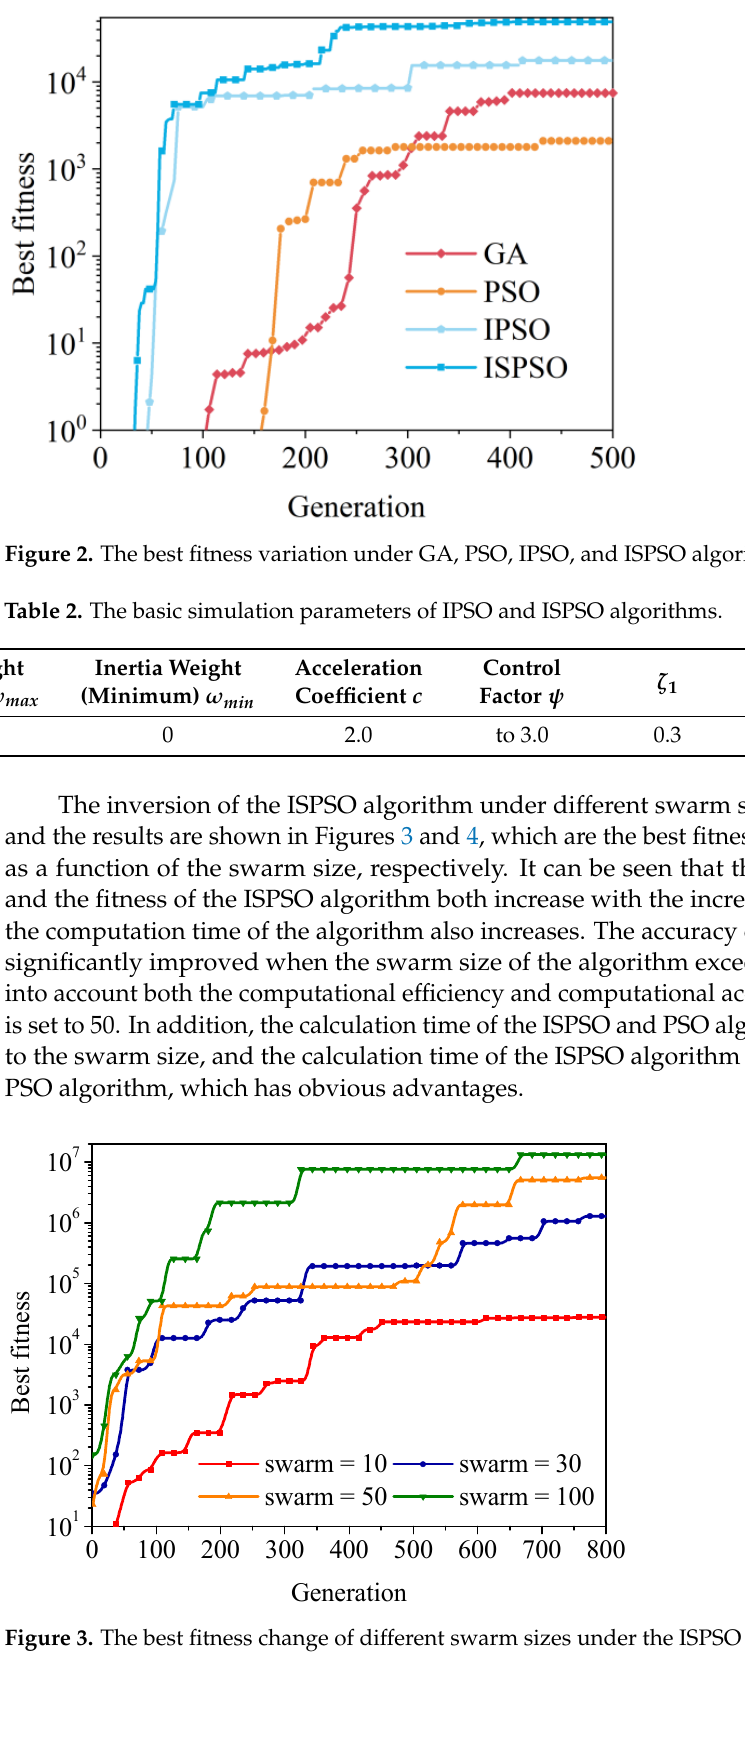
Figure 4. Computation time as a function of swarm size under different algorithms.